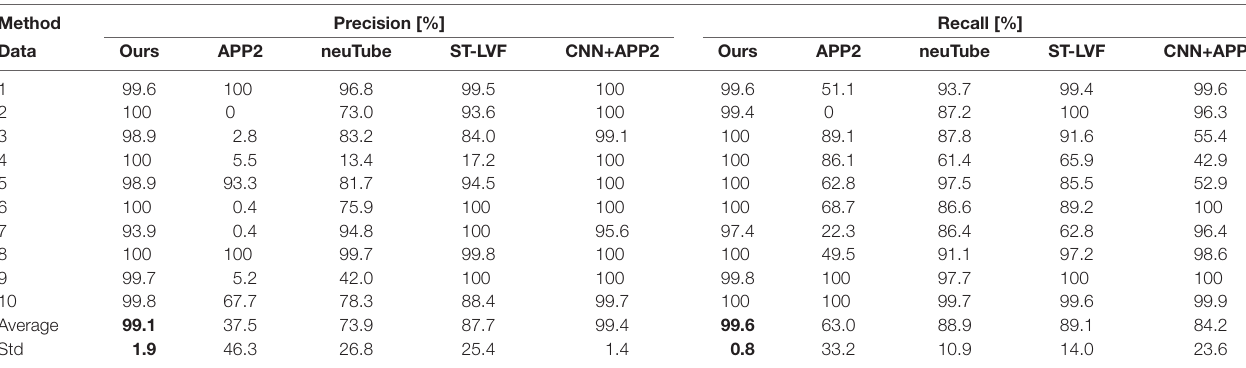
TABLE 2 | Quantitative evaluation of the proposed and state-of-art methods on fMOST datasets.